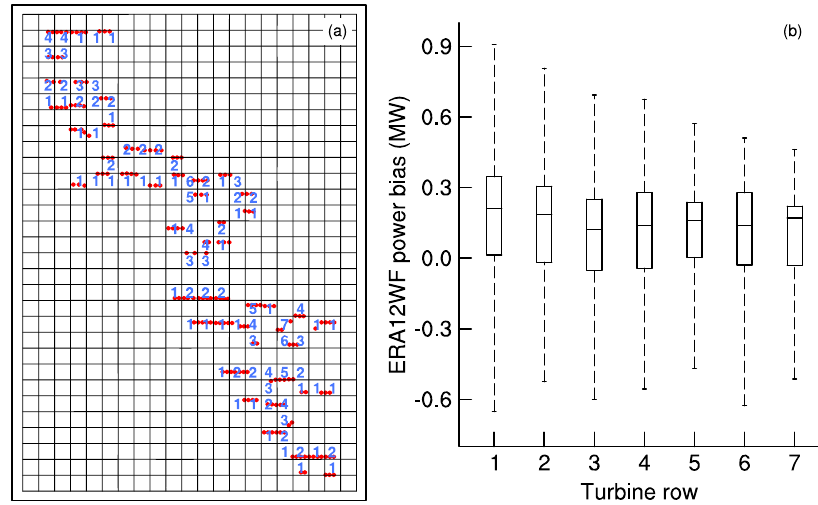
Figure 12. Map of the wind farm where the blue numbers represent the row number from the upwind row during southerly winds (a) . The upwind row number is reset to 1 when the next two downwind grid boxes to the north contain no turbines. Box plot of the average ERA12WF power bias normalized over different number of wind turbine rows, when the hub-height WD in the grid cell closest to the WC is between 175 and 185 ◦ (b)